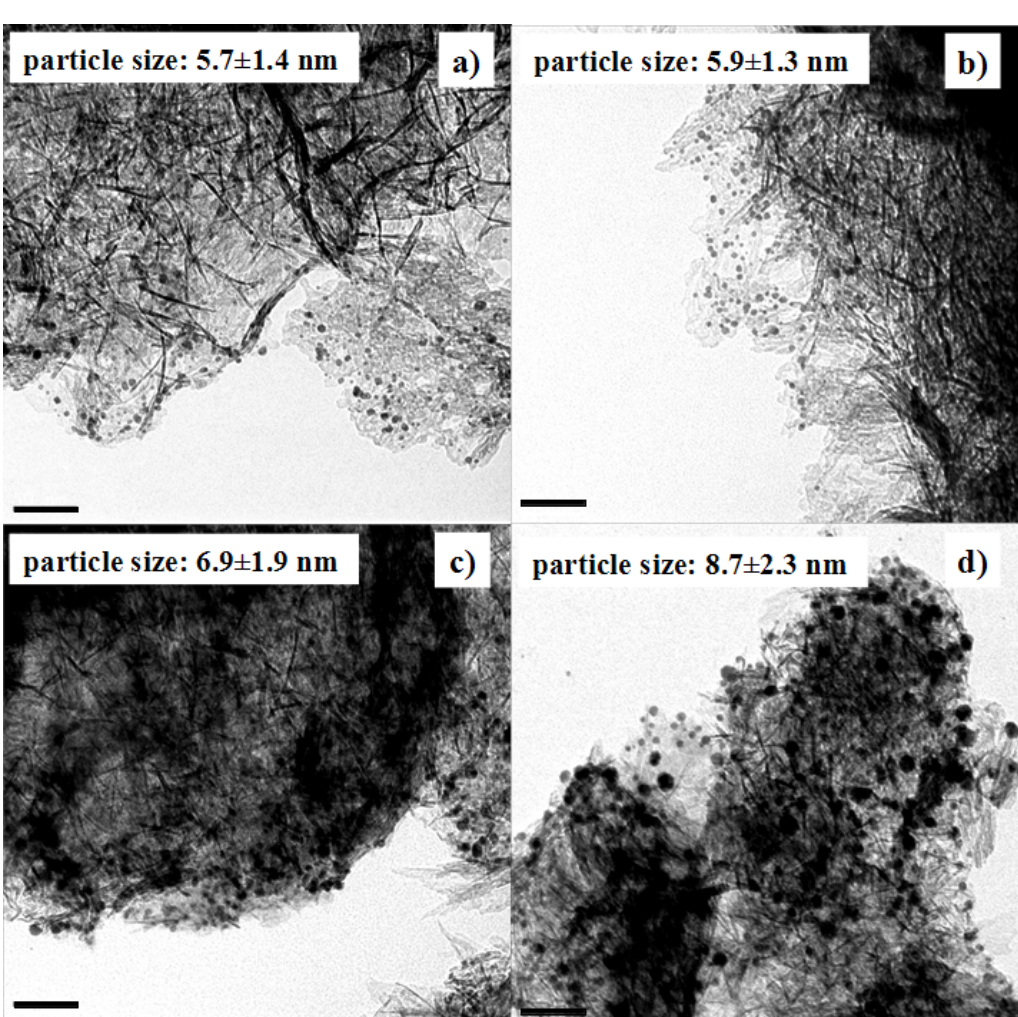
Figure 4. TEM images of Au/Al O catalysts with Au colloid solutions adjusted to 2 3 different pH values. ( a ) pH = 5.9; ( b ) pH = 3.5; ( c ) pH = 2.6; ( d ) pH = 1.9. The scale bars represent 50 nm. The size of the original Au colloid before pH adjustment is 5.7